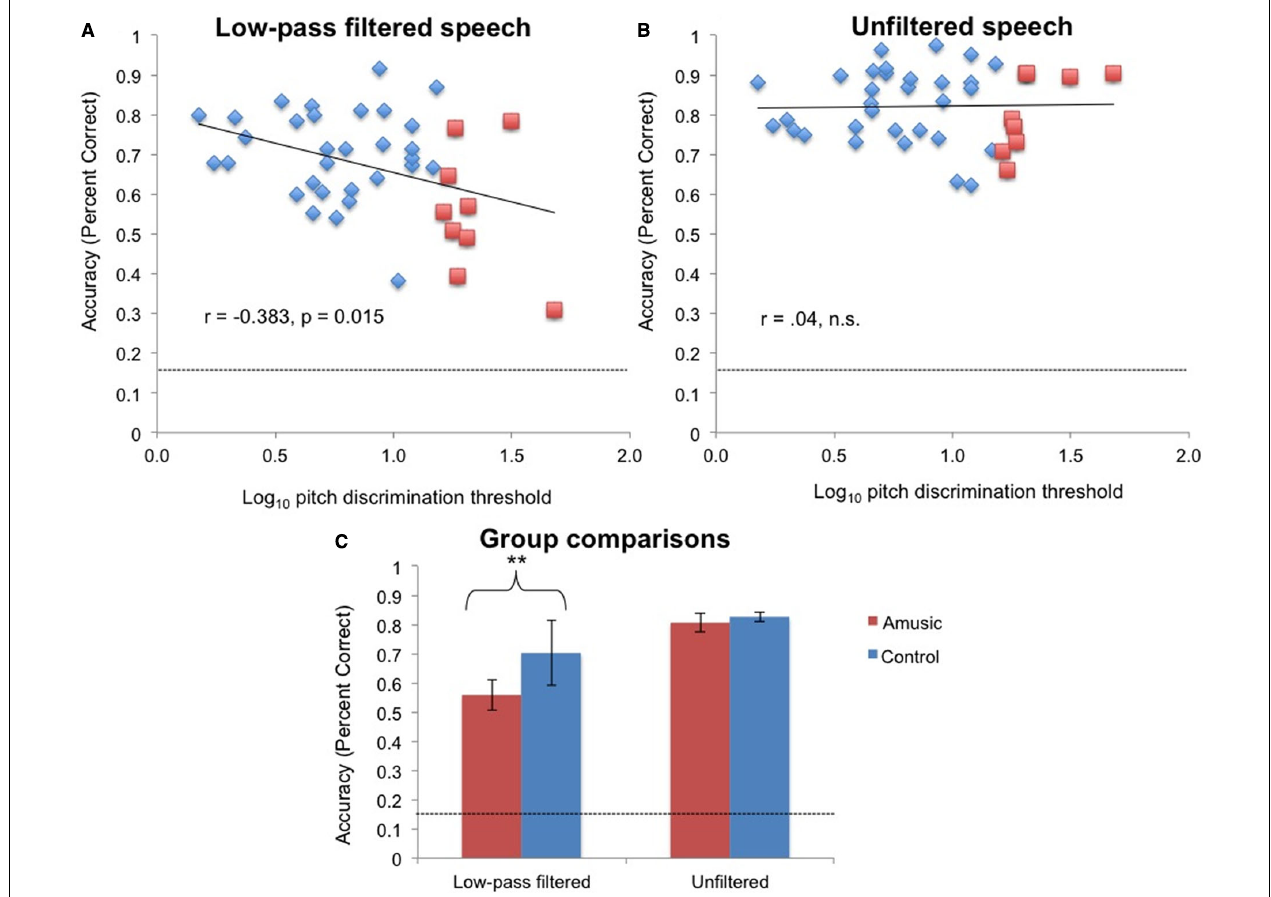
FIGURE 3 | The relationship between log pitch discrimination threshold and emotional identification accuracy (A) in the low-pass condition and (B) in the unfiltered speech condition. Red squares: amusics; blue diamonds: controls. Dashed line indicates chance performance. (C) Accuracy in emotional identification in amusics and control subjects. ** p <